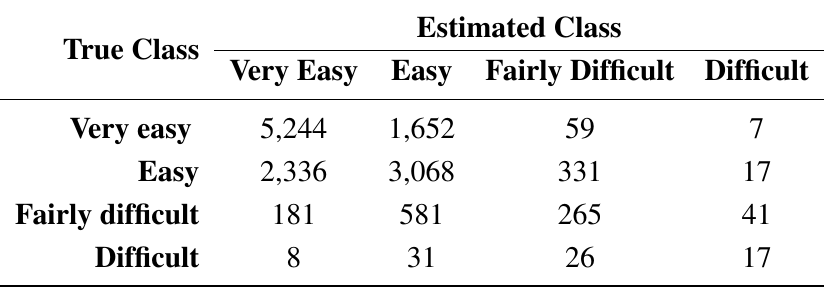
Table 5. Confusion matrix for system #1T1 on training corpus on task 1.